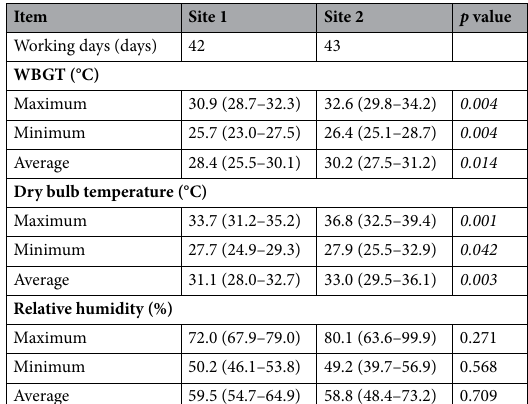
Table 2. Environmental data. Italic font describes significant difference ( p < 0.05). n or median (25–75 percentile). P value was calculated by using the Wilcoxon rank sum test.